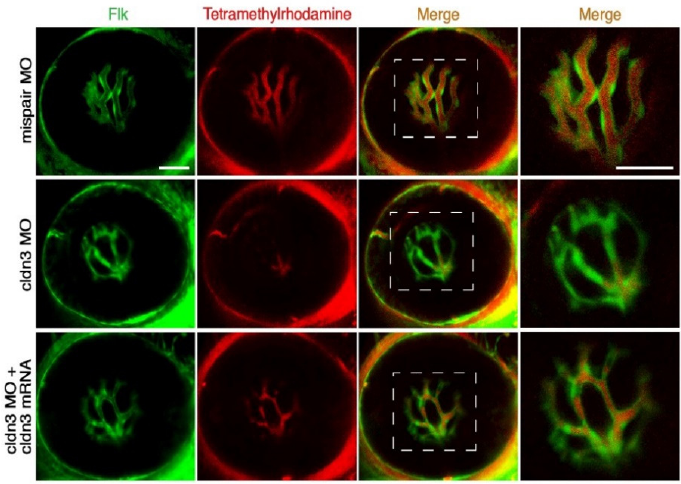
Figure 2. Lumen formation analyses of the hyaloid vessels in the 5 dpf zebrafish. More severe filling defects (more non-perfusion areas) of hyaloid vessels were observed in the cldnh MOs-injected zebrafish as compared to the mispair MO-injected or the cldnh mRNA-rescued zebrafish, indicating lumenization defects of the hyaloid vessels in the cldnh knockdown group. Scale bar: 50 μ m [22].